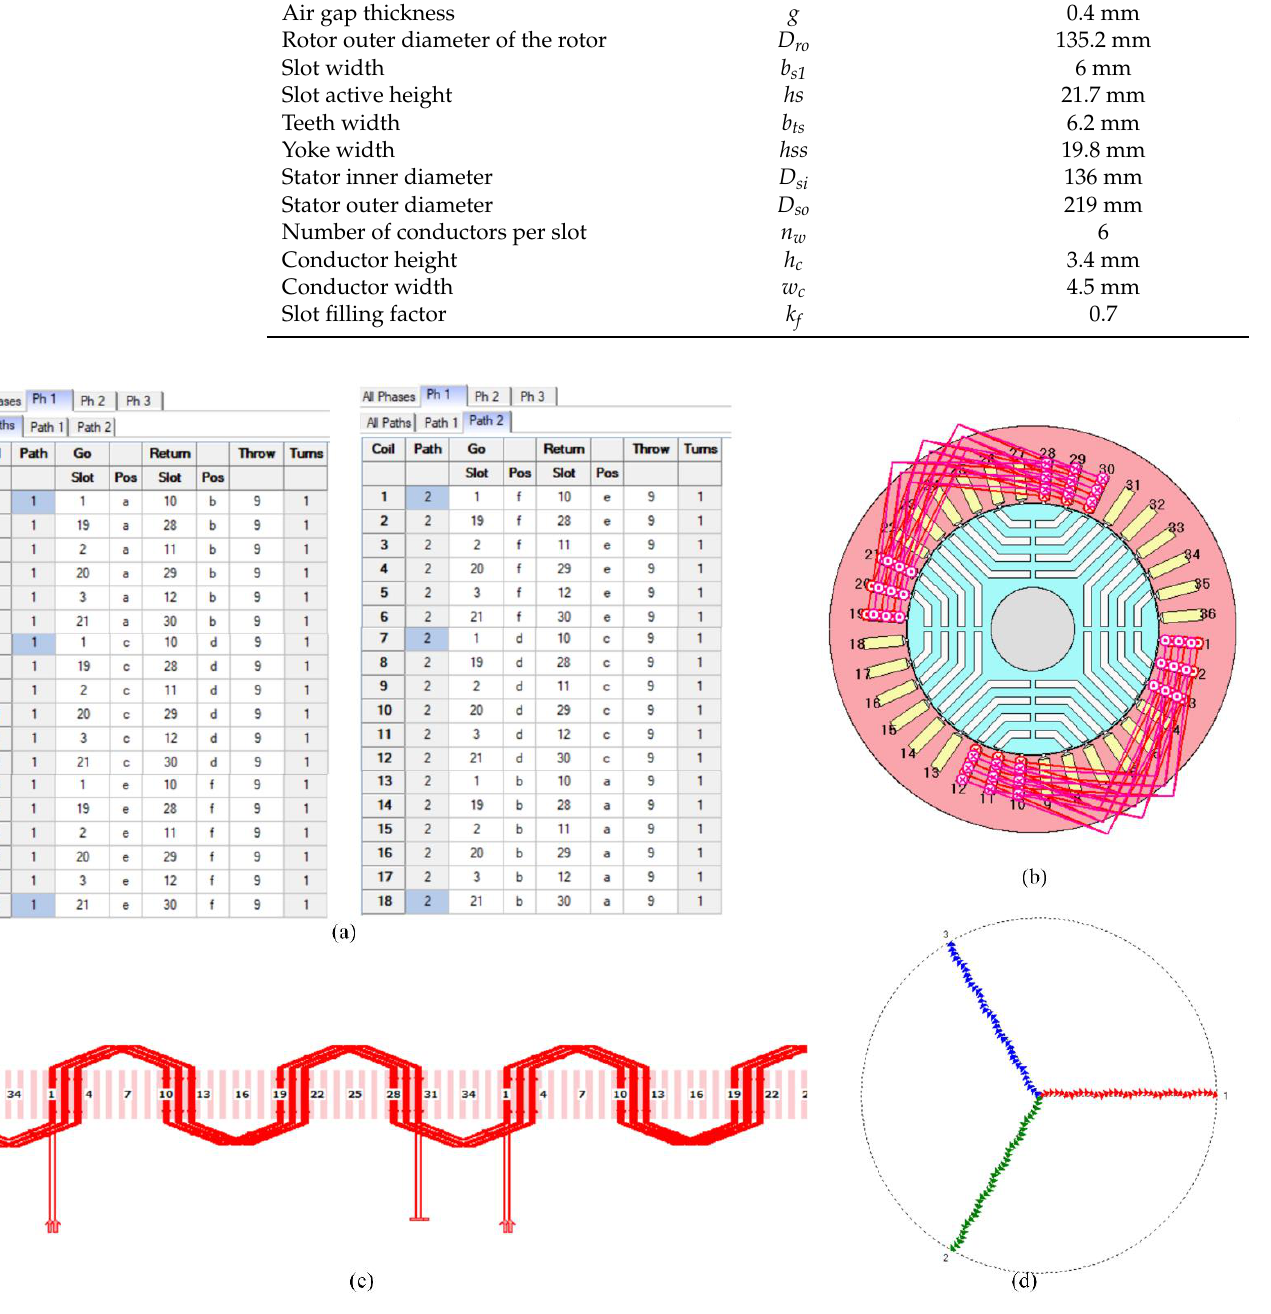
Figure 3 . Modeling the hairpin winding configuration with six-layer conductors with Motor-CAD: ( a ) the table of transposition of windings, ( b ) coil arrangement of phase one, ( c ) linear view of coil arrangement of phase one, and ( d ) phasor diagram of the windings.